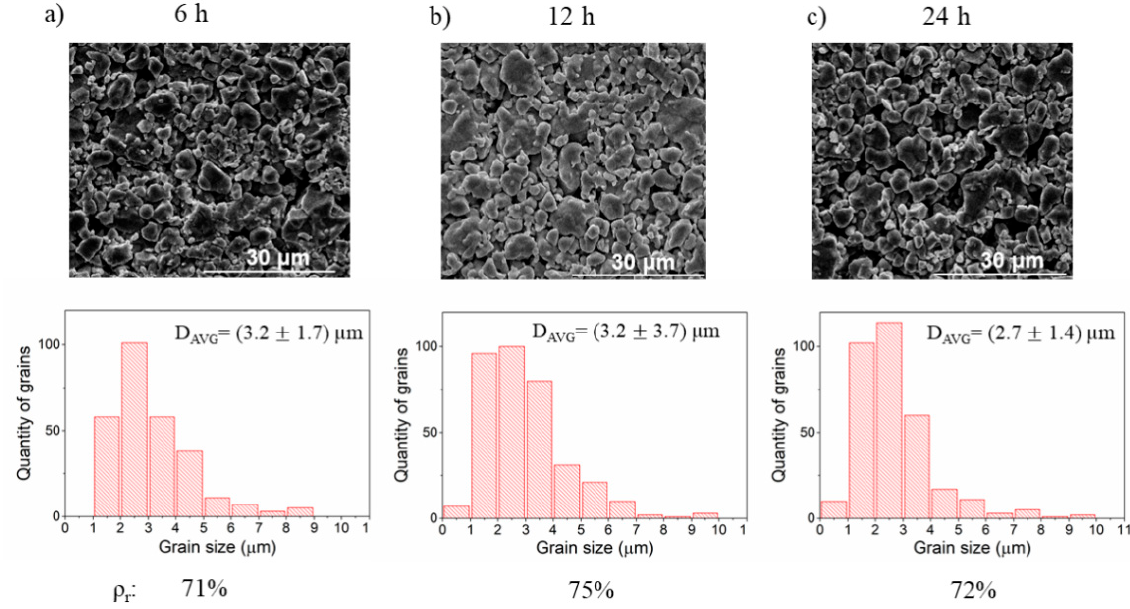
Figure 8. The SEM images, grain size distribution, and relative density ρ r of ceramics annealed at 1100 °C for ( a ) 6 h, ( b ) 12 h, and ( c ) 24 h.